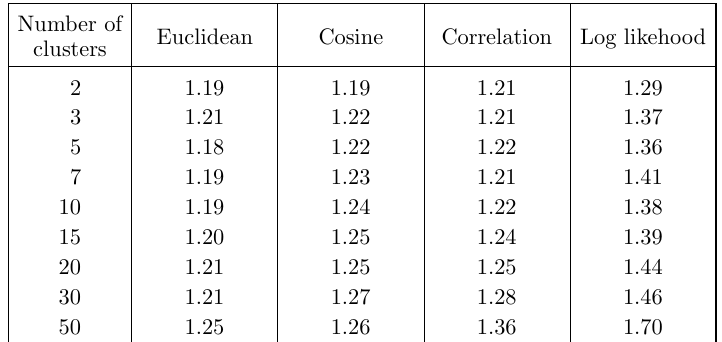
Evaluation ( RMSE ) of recommendation system based on k-means clustering algorithm and the most frequent representative values of clusters